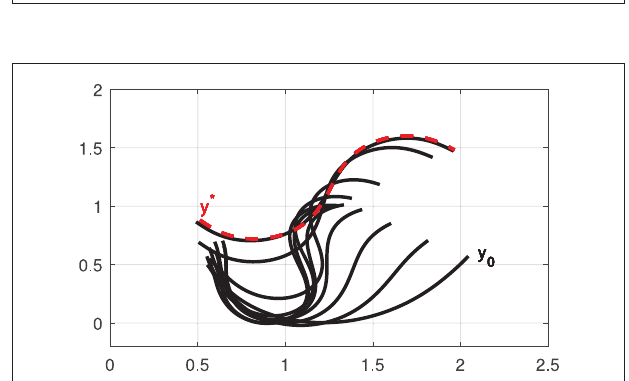
FIGURE 8 | Representation of a two-robot setup where both systems must jointly shape the cable into a desired form.